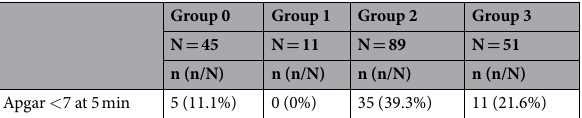
Table 6. Apgar score in the 196 neonates for whom metabolic testings were performed. Group 0: neonates with a final diagnosis of transient disorder; group 1: neonates diagnosed with IMD confirmed by molecular testing; group 2: neonates suffering from a non-metabolic disease; group 3: neonates with chronic clinical abnormalities but for whom no diagnosis could be made.